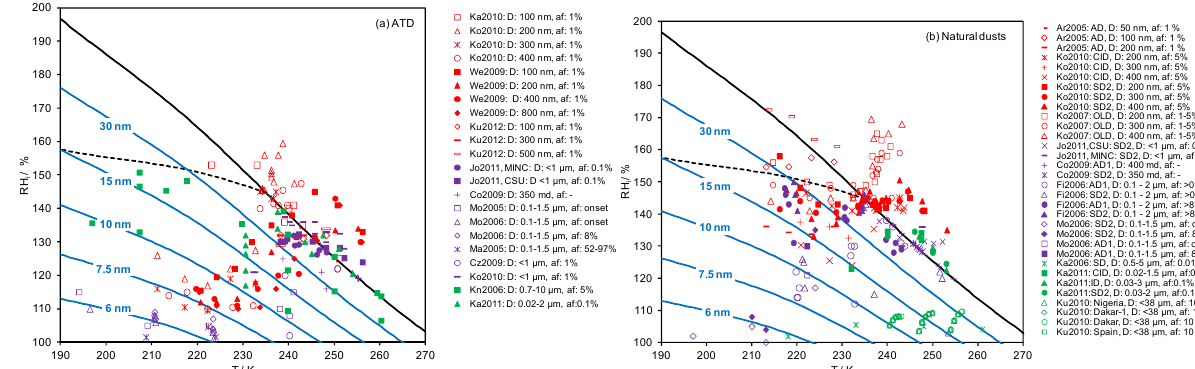
Fig. 6. Ice nucleation data as a function of temperature and relative humidity with respect to ice (RH i ) for (a) Arizona Test Dust (ATD) and (b) natural dusts. Red, purple and green symbols encode nucleation on submicron, micron, and supermicron particles, respectively. The solid and dashed black lines indicate liquid water saturation and homogeneneous ice nucleation, respectively. The solid light blue lines give pore filling in dependence on pore diameter. The legend lists the reference of the study, the source of the dust in the case of natural dusts, the diameter of the particles ( D ) and the active fraction (af). Abbreviations: AD, Asian Dust; CID, Canary Island Dust; SD2, Saharan Dust from Cairo; OLD: Owen Lake Dust; AD1, Asian Dust; SD, Saharan Dust; ID, Isreali Dust. References: Ka2010, Kanji and Abbatt (2010); Ko2010, Koehler et al. (2010); We2009, Welti et al. (2009); Ku2012, Kulkarni et al. (2012); Jo2011, Jones et al. (2011); Co2009, Connolly et al. (2009); Mo2005, Möhler et al. (2005b); Mo2006, Möhler et al. (2006); Ma2005, Mangold et al. (2005); Cz2009, Cziczo et al. (2009); Kn2006, Knopf and Koop (2006); Ka2011, Kanji et al. (2011); Ar2005, Archuleta et al. (2005); Ko2007, Koehler et al. (2007); Fi2006,